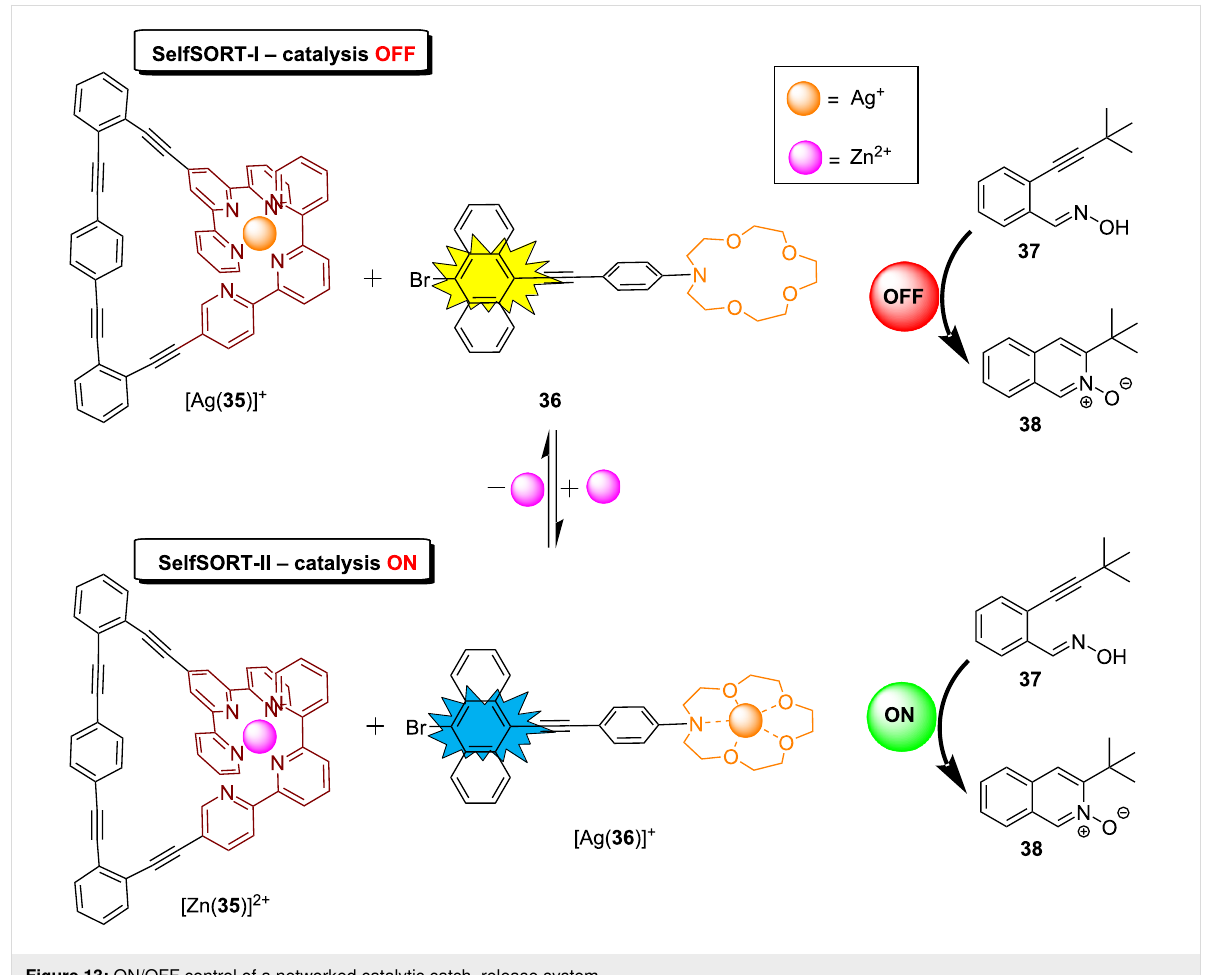
Figure 13: ON/OFF control of a networked catalytic catch–release